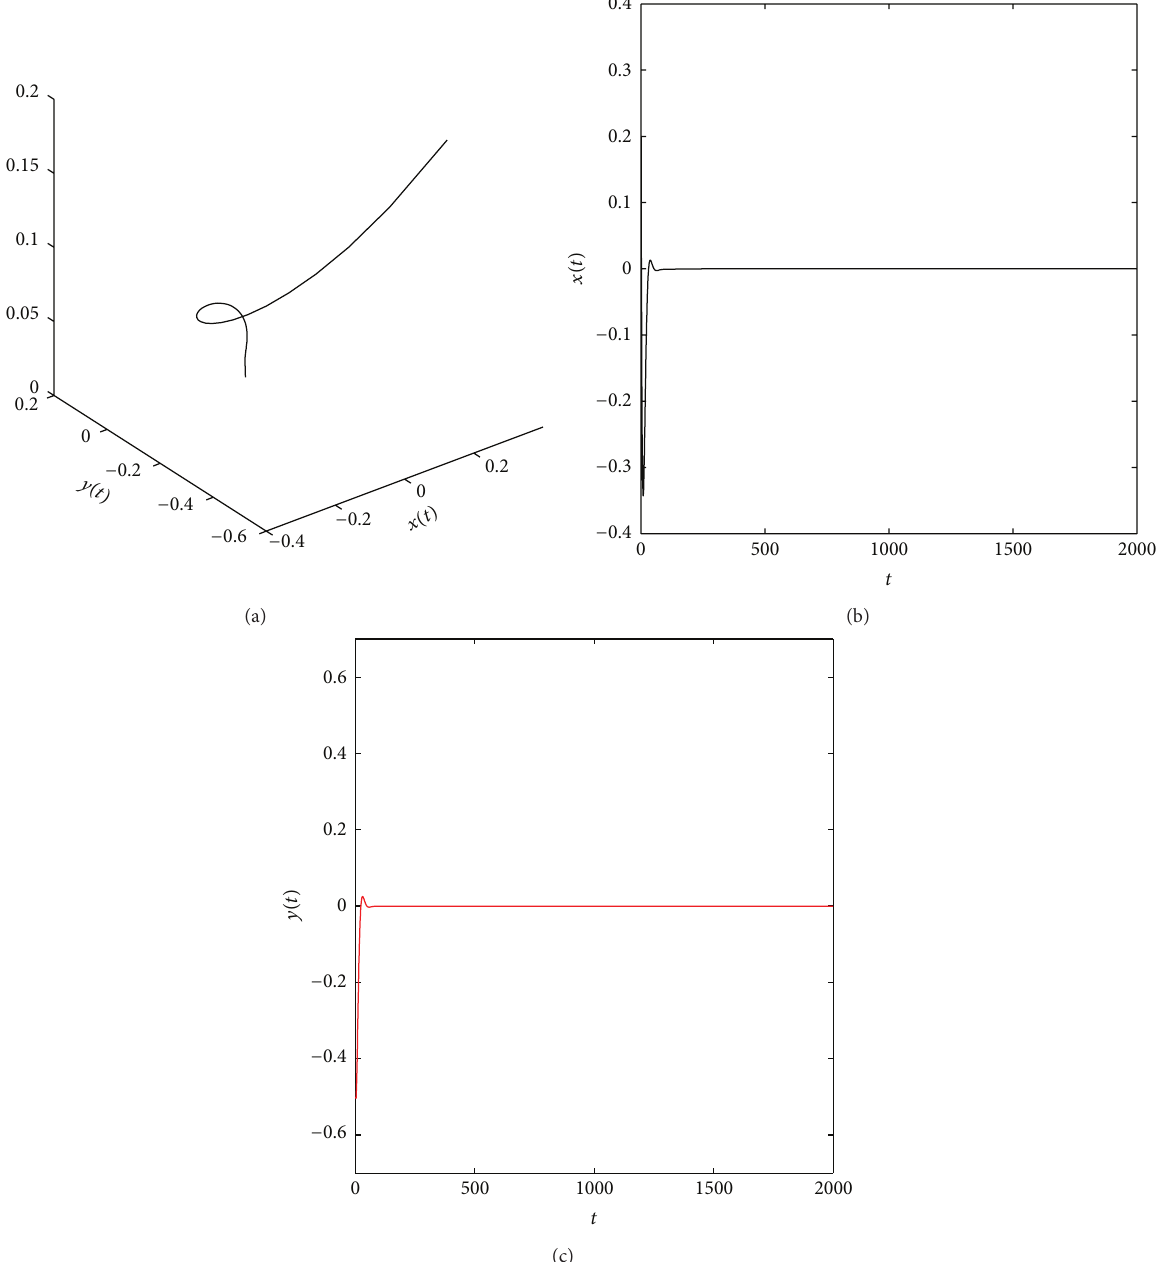
Figure 2: The equilibrium point ̂𝑥 1 of the distributed order fractional Chen system (22) with ( 𝑞 1 , 𝑞 2 ,𝑞 3 ) = (0.95, 0.9, 0.9) and (𝑎,𝑏, 𝑐) = (35, 6,11) is asymptotically